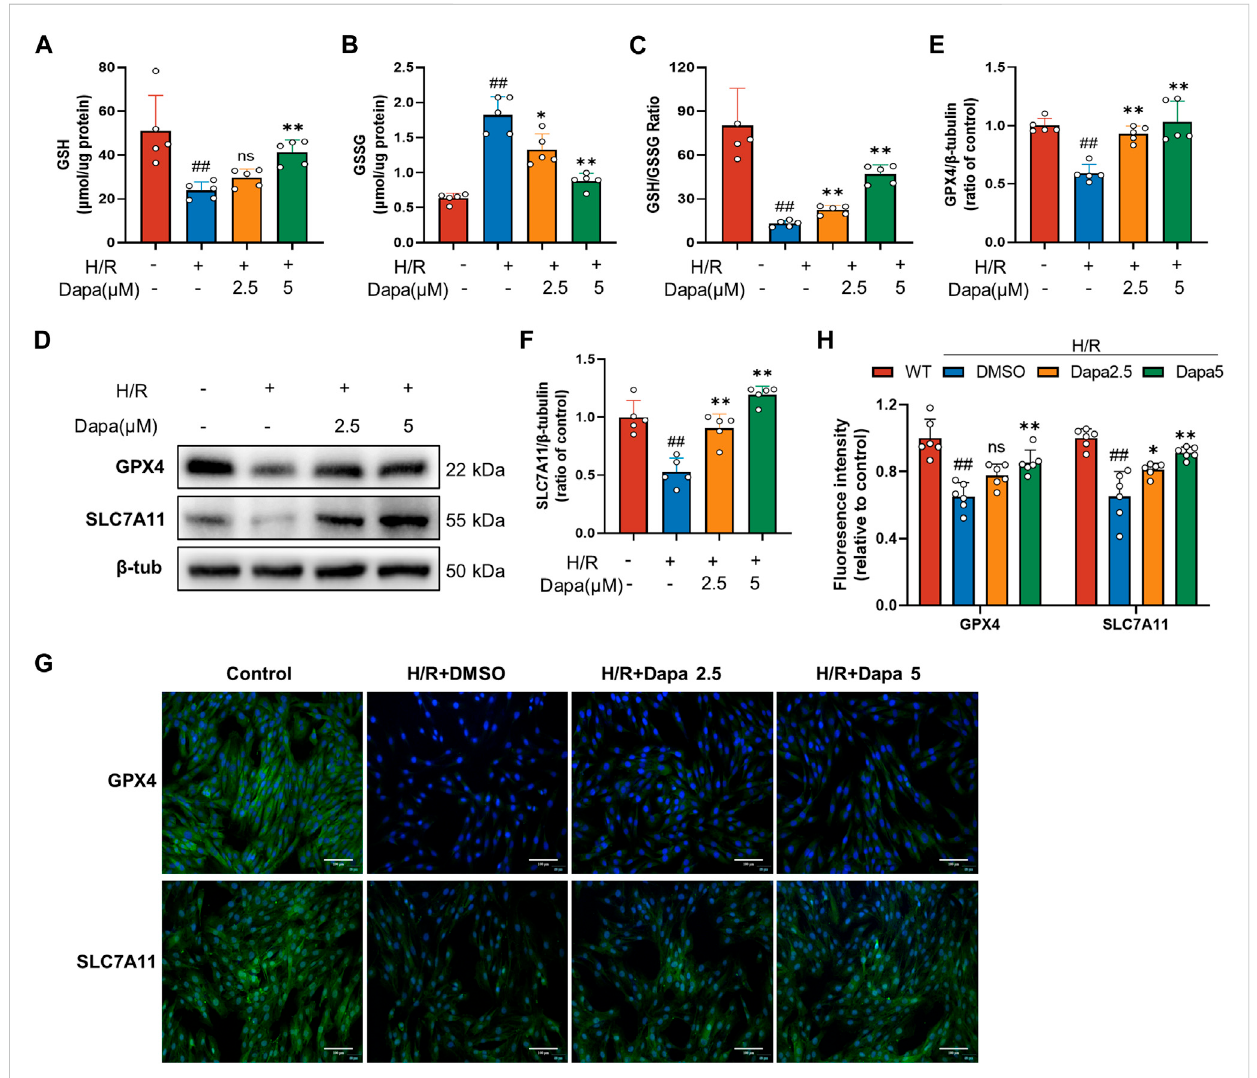
FIGURE 3 Dapagli fl ozin improves the glutathione antioxidant system in H/R. (A – C) GSH, GSSG and GSH/GSSG ratio changes in H9C2 cells assayed by a commercial kit ( n = 5 per group). (D – F) The protein levels of GPX4 and SLC7A11 were measured by western blotting. Relative densitometry values are shown( n =5pergroup). (G,H) Representativeimmuno fl uorescenceimagesofGPX4andSLC7A11(scalebar,100 μ m)andquantitativeanalyses( n =6per group).Dataareexpressedasmean±SD;One-wayANOVAfollowedbyTukey ’ scorrectionfor posthoc multiplecomparisonsorDunnett ’